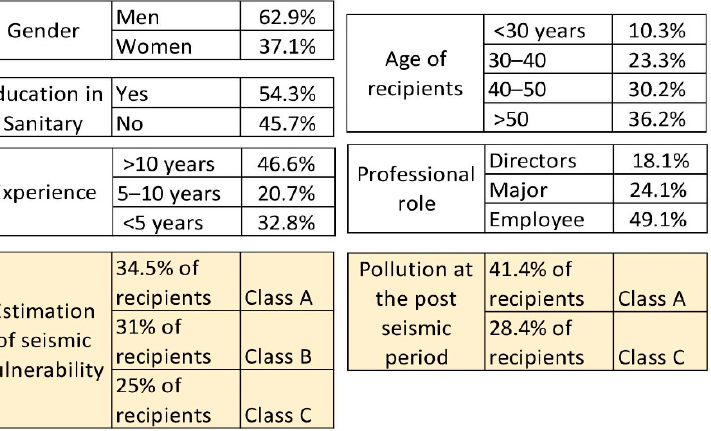
Figure 5. Demographic characteristics of the recipients and estimation of seismic vulnerability of the WWTPs.